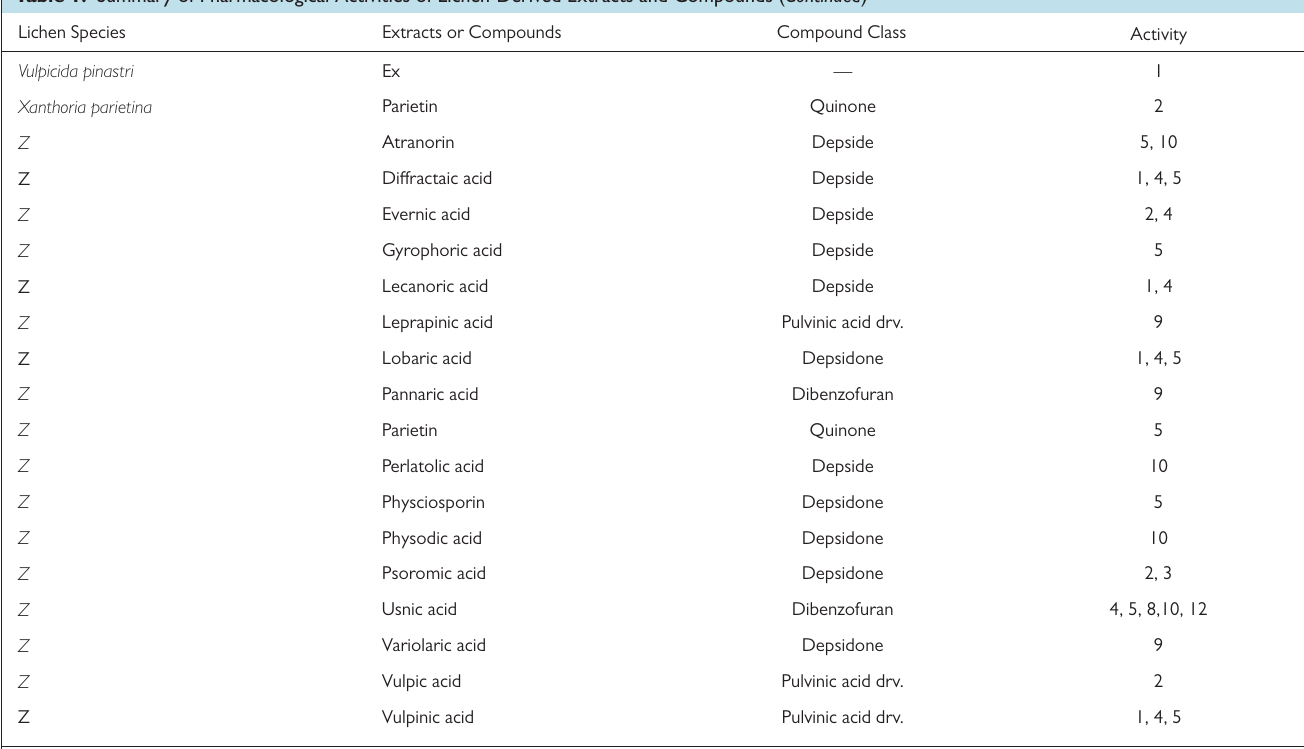
Table 1. Summary of Pharmacological Activities of Lichen-Derived Extracts and Compounds ( Continued